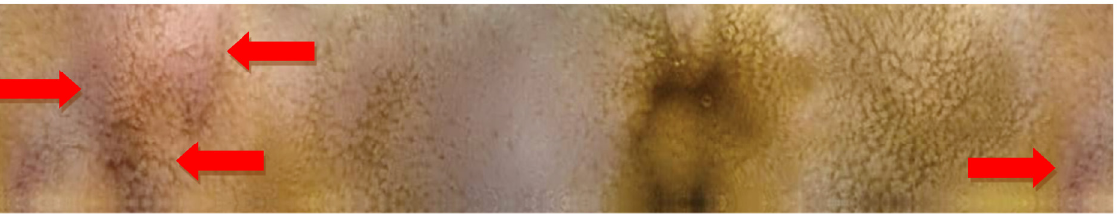
Figure 6. Video capsule enteroscopy. Porcine ileum. Focal mucosal erythema